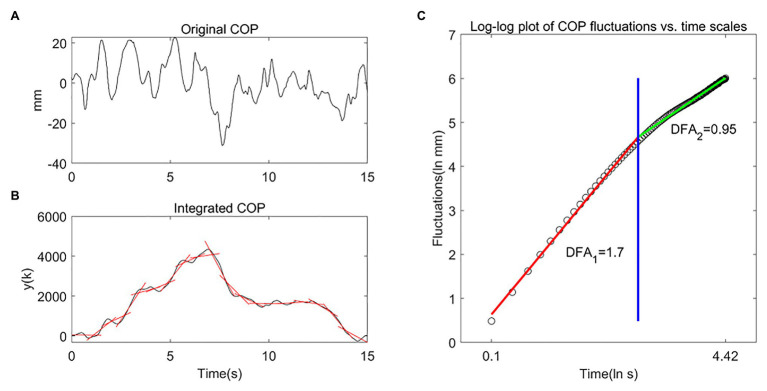
Detrended fluctuation analysis (DFA) method and DFA coefficients. (A) Original COP signal in the anterior-posterior (AP) direction from a 4-year-old child under the condition of ECHB during 15 s. (B) Integrated COP signal y(k), the red solid line represent the linear trend in each box with 50% overlap. (C) Log-log plot of COP fluctuations vs. time scales, DFA1 (red line) and DFA2 (green line) reflect the COP fluctuations at shorter (to the left of the blue line) and longer (to the right of the blue line) time scales, respectively.